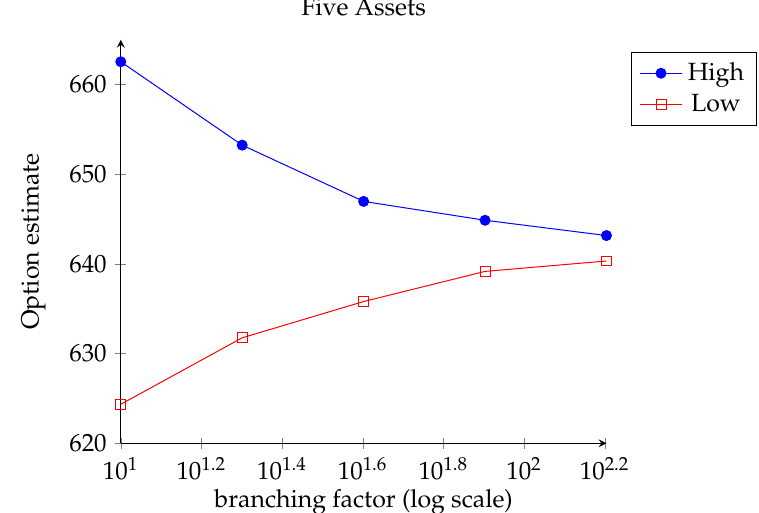
Figure 5. Option value estimates (USD) vs. log branching factor ( b ) with a five-dimensional underlying. The option has one up and one down swing right, three exercise opportunities, exercise volume of 60 units and there is no usage penalty. The number of repeated valuations R = 32000 standard errors ≈ 0.09% of option